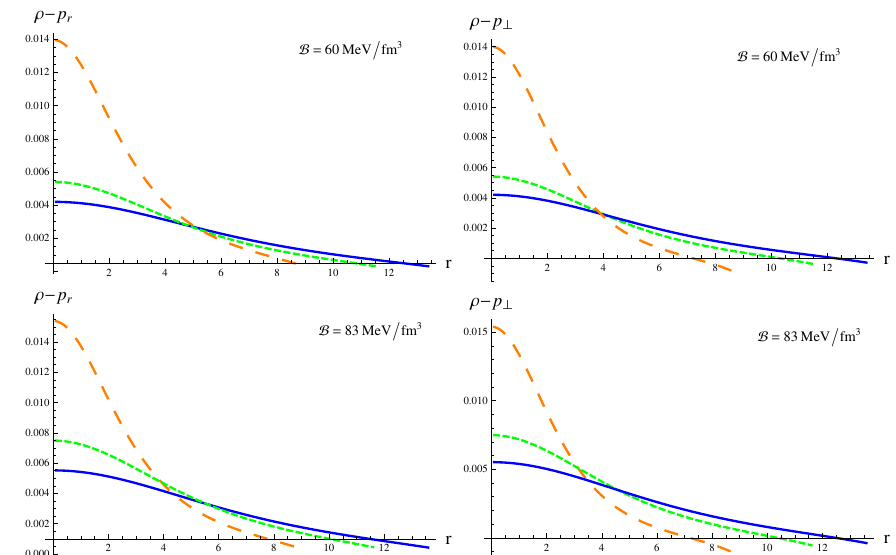
Figure 5. DEC (with ρ , p r , p ⊥ in km − 2 ) against the radial coordinate (in km) for m Ψ = 0.001.